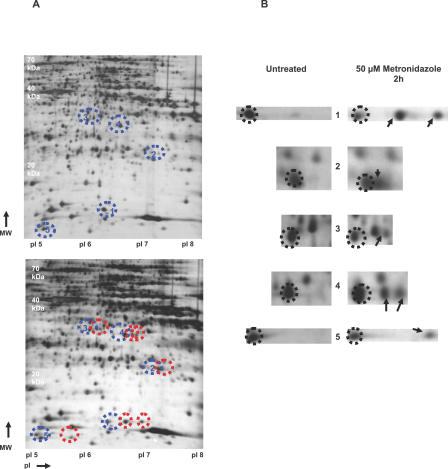
2DE of E. histolytica Cell Extracts Reveals Adduct Formation upon Metronidazole Treatment(A) The adducts formed can be identified as shifts to more basic pI values on 2D gels. Cells were treated with 50 μM metronidazole for 2 h or left untreated. Isoelectric focusing was performed between pH 5 and pH 8; SDS PAGE was run on 12.5% polyacrylamide gels. The proteins are marked on a section of the 2D gel of the untreated sample (upper gel image) and of the treated sample (lower gel image).Protein 1: metronidazole target protein 1 (two shifts); protein 2: superoxide dismutase (one shift); protein 3: purine nucleoside phosphorylase (one shift); protein 4: thioredoxin reductase (two shifts); and protein 5: thioredoxin (one shift). Unmodified proteins are marked by blue dotted circles, and shifted proteins are indicated by red circles.(B) The same proteins in a close-up: unmodified proteins are encircled, and the respective modified isoforms are indicated by arrows.